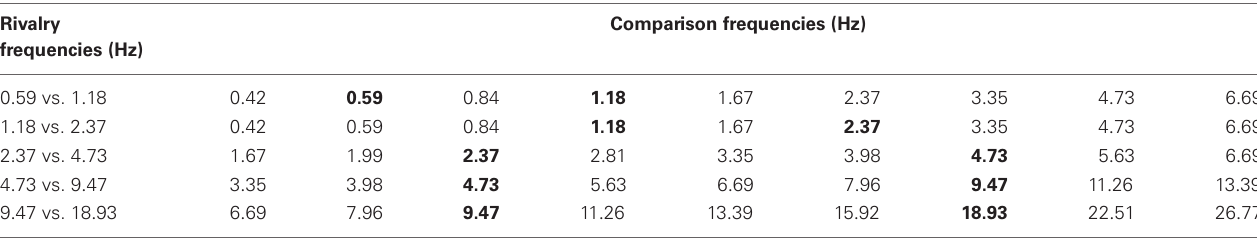
Table 2 | A summary of the temporal frequencies of the rivalry stimuli used in Experiment 2B (left-hand side: all are one-octave pairs) and the corresponding nine comparison stimuli for each rivalry